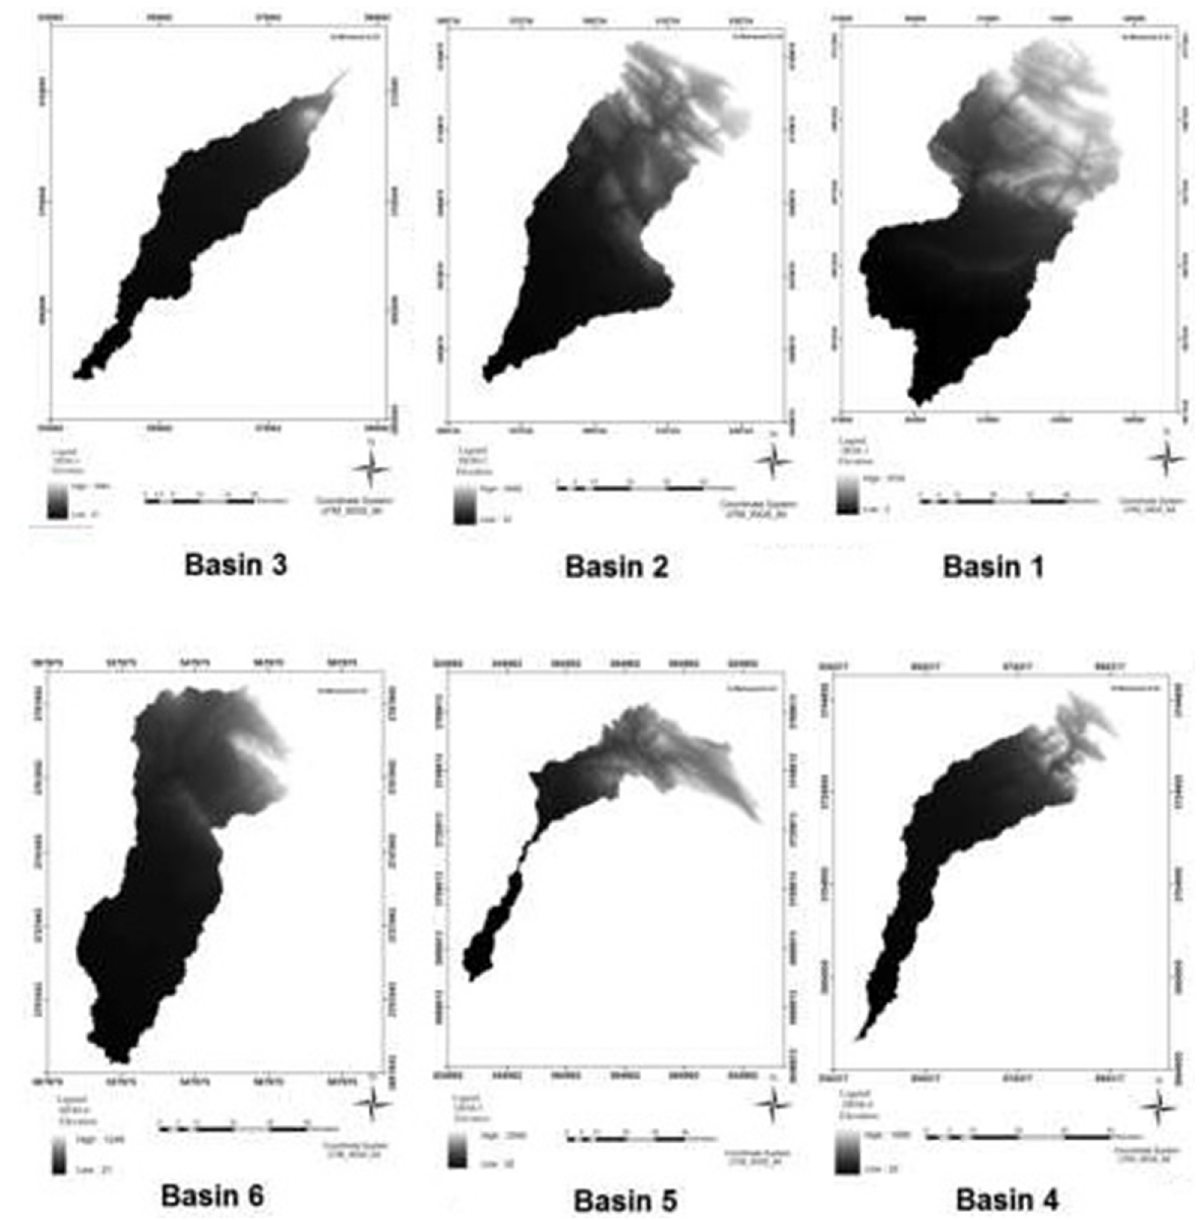
Figure 3: The six basins fl ow into the Al - Shewicha trough [ 15 ]